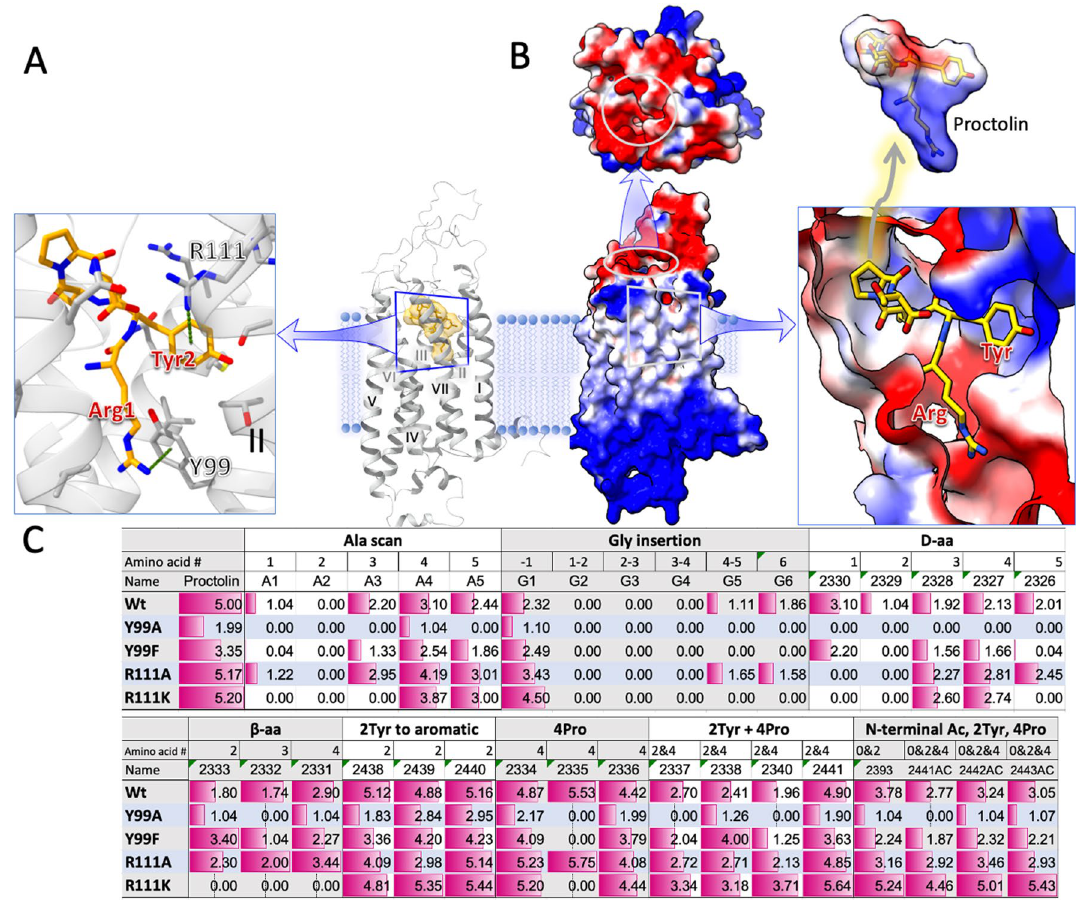
Figure 2. In silico docking model. The importance of cation-π interactions of Arg1 and Tyr2 of the proctolin ( A ), the charges of receptor and ligands on the docking model ( B ), and the mutated ligands and receptor activities tested on the receptors expressed in the CHO cell ( C ). In B, blue is for positive and the red is for negative charges. In C, the values are normalized values for the log10-based scale activities relative to the 5 as the standard for wild-type receptor with the